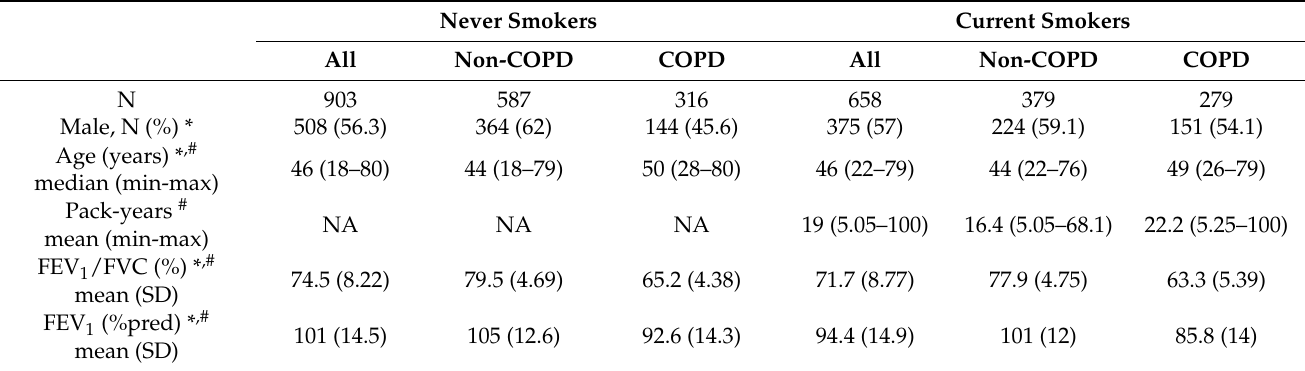
Table 1. Subject characteristics of Lifelines cohort.